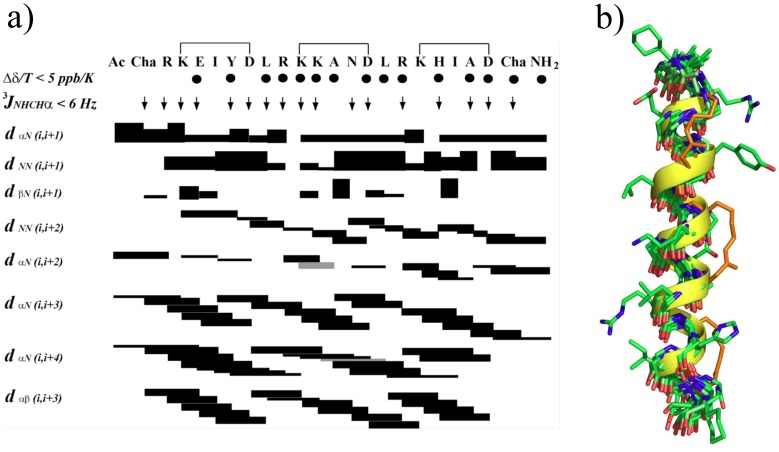
NMR Structure of peptide 24.
a) NOE summary diagram for peptide 24 in 90% H2O:10% D2O at 298 K. Sequential, short and medium range NOE intensities were classified as strong (upper distance constraint 2.7 Å), medium (3.5 Å), weak (5.0 Å), very weak (6.0 Å) and are proportional to bar thickness; grey bars indicate overlapping signals. 3
J
NHCHαcoupling constants <6 Hz are indicated by ↓. Amide NH’s for which chemical shifts changed by <5 ppb/K are indicated by •. b) Backbone superimposition for ten lowest energy NMR-derived solution structures for Ac-cyclo-(3,7; 10,14; 17,21)-ChaR[KEIYD]LR[KKAND]LR[KHIAD]Cha-NH2 (24) in H2O:D2O (9∶1) at 298 K showing carbon atoms (green), nitrogens (blue), oxygens (red), i→i+4 hydrocarbon constraints (orange). Also for clarity, one structure is shown with its alpha helical backbone (yellow) and projecting side chains (green). N-terminus is at the top.